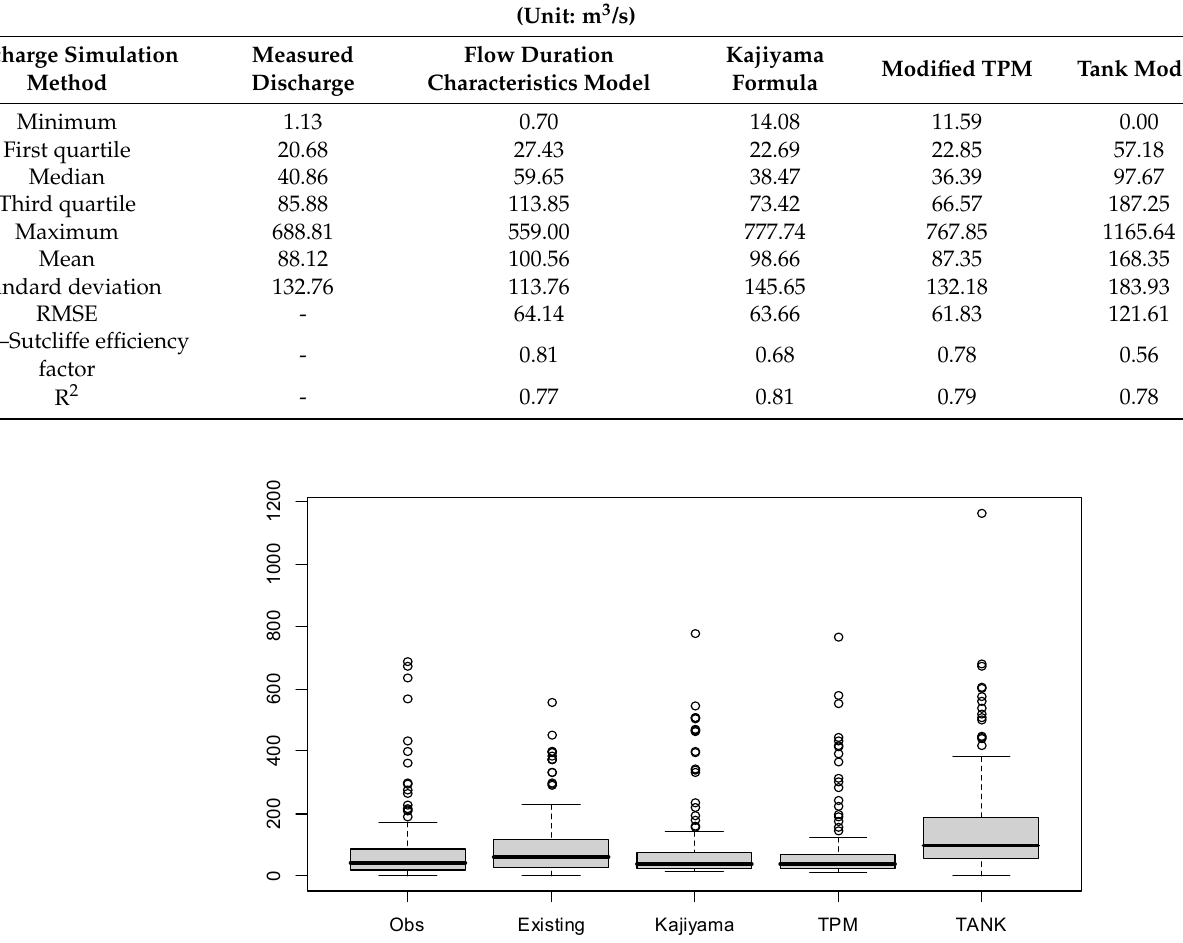
Table 7. Comparison of the distribution and statistics of the simulated and measured monthly average discharge for the Hanseok SHP plant. (Unit: (cid:1813) (cid:2780) /(cid:1819))